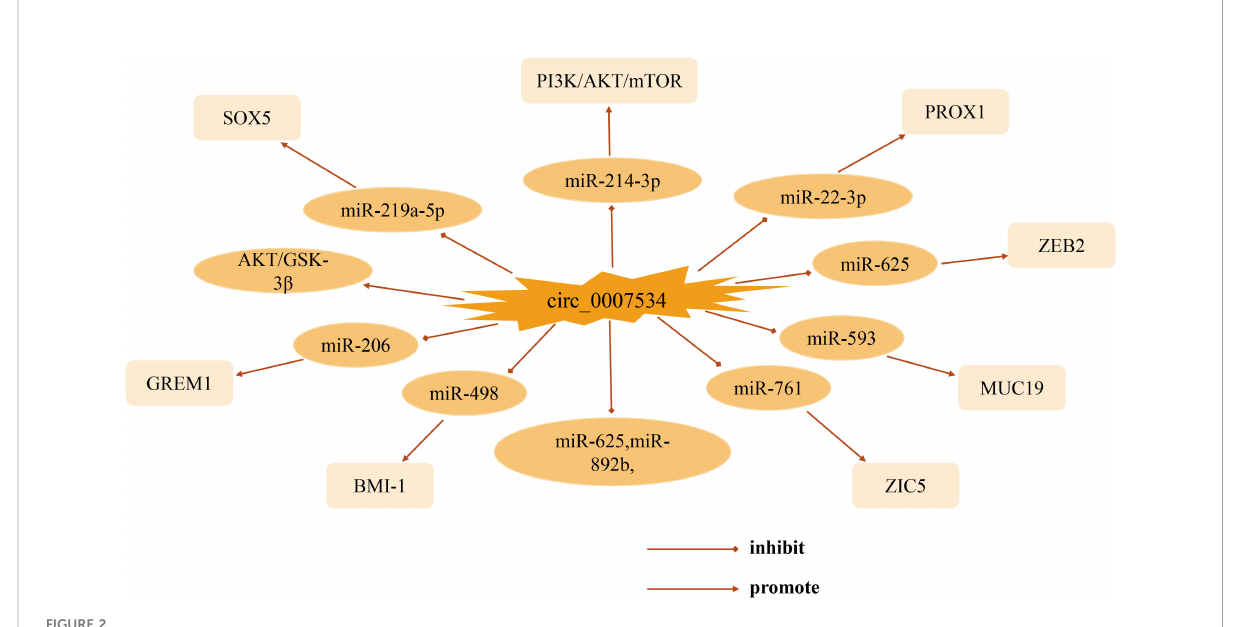
FIGURE 2 Mechanisms of circ_0007534 regulating various